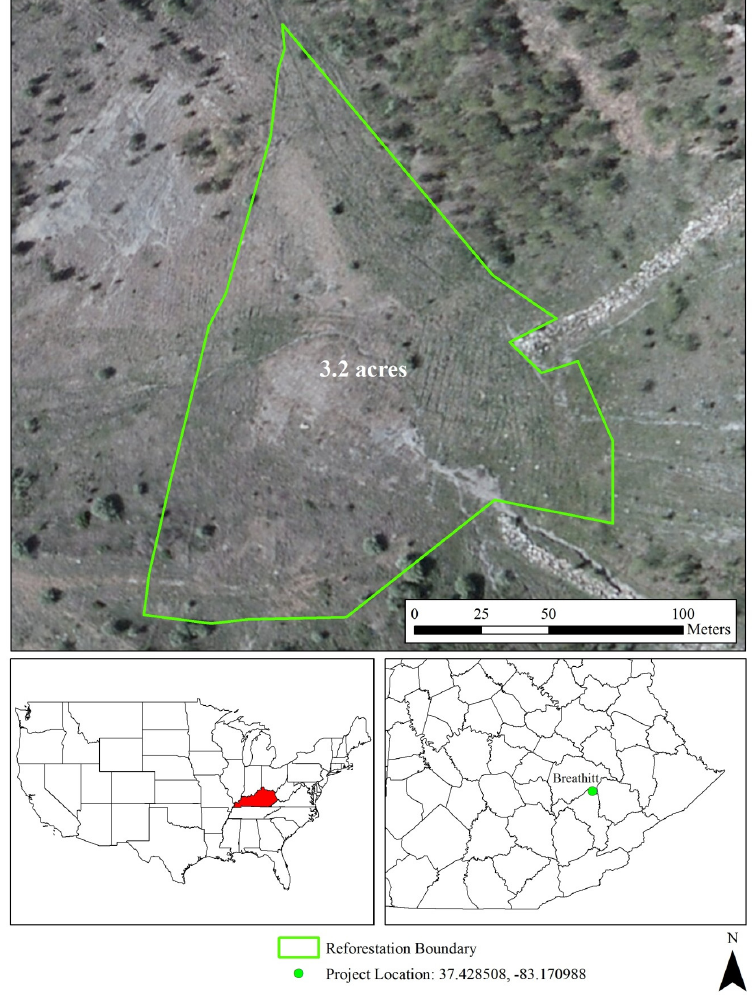
Figure 1. Plot location, Breathitt County, KY. (Figure credit: Kylie Schmidt).